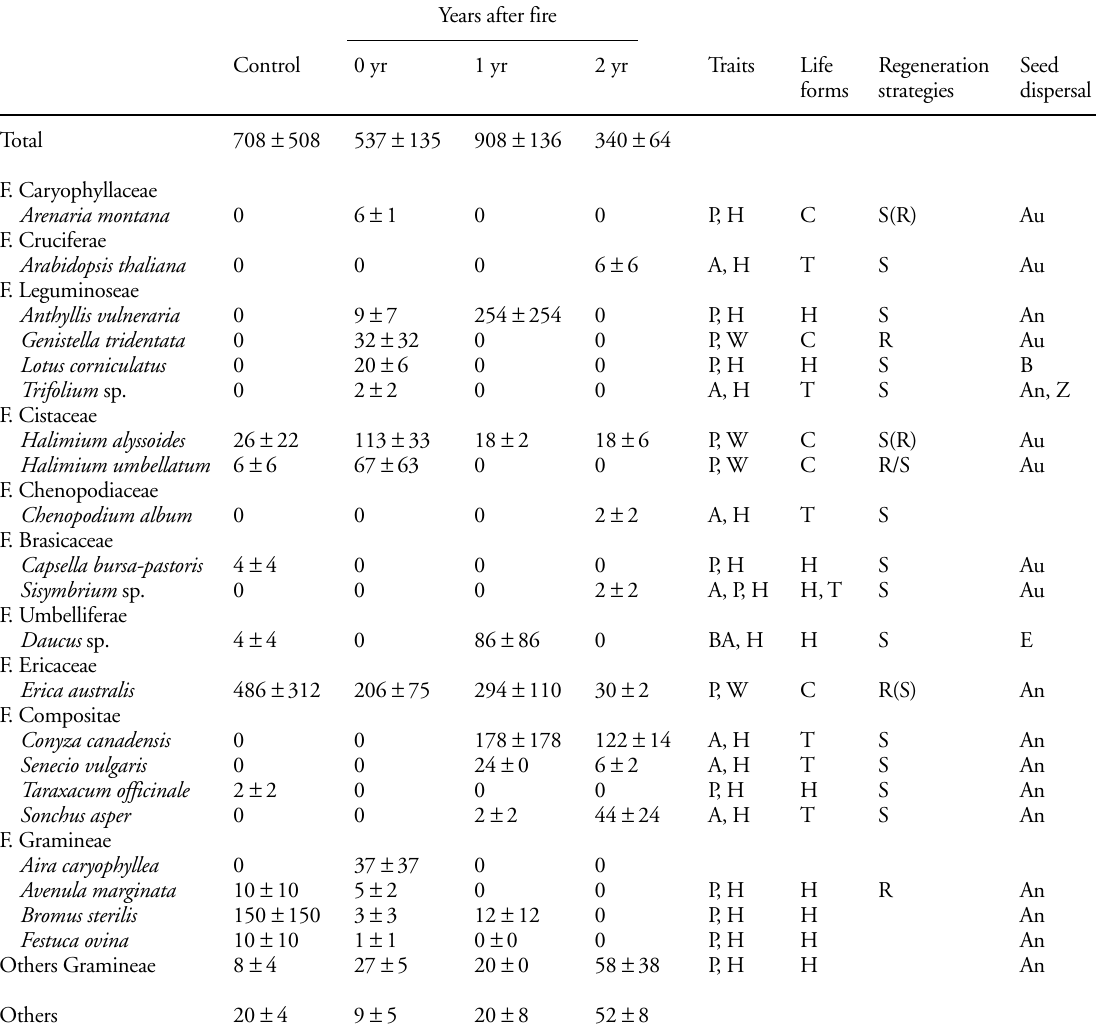
Table 1. Mean density ± SE of the seeds present in the soil seed bank in the control situation and in time after fire (0, 1, 2 yr) of the three sites (A, B and C). Traits: H = Herbaceous species, P = Perennial species, A = annual species, BA = biannual species, W = Woody species. Life forms: H = Hemicryptophyte, T = Therophyte, C = Chamaephyte. Regeneration strategies: S = Seeders, R = Resprout, S/R = Seeders and resprouters. Seed dispersion types: An = Anemochory, Au = Autochory, E = Epizoochory, B = Barochory and Z =